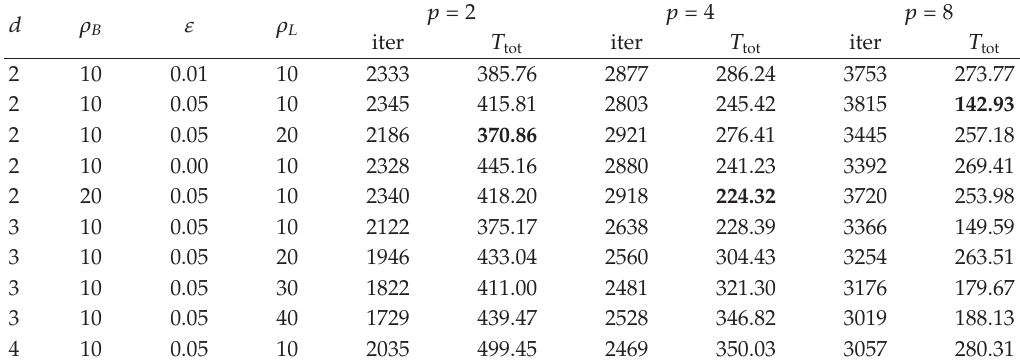
Table 3: Performance of BFSAI-DACG for matrix PO-878 with 2 to 8 processors and di ff erent parameter values.